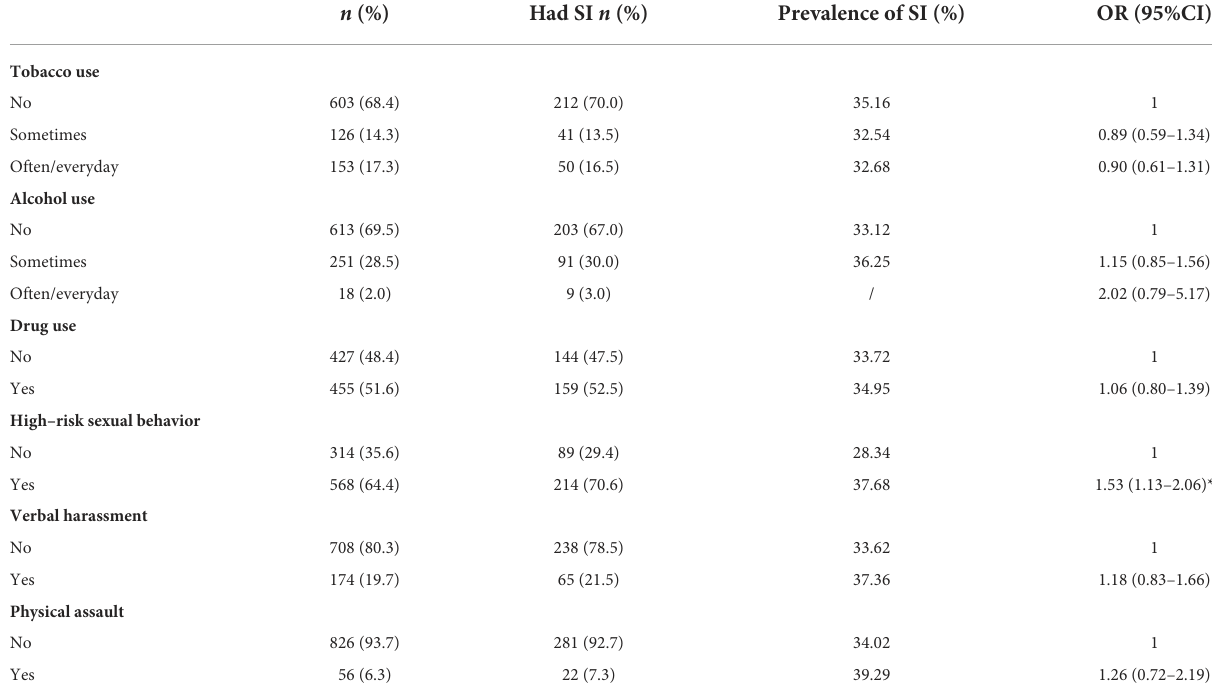
TABLE 2 Triggering events and their associations with suicidal ideation ( n = 882).